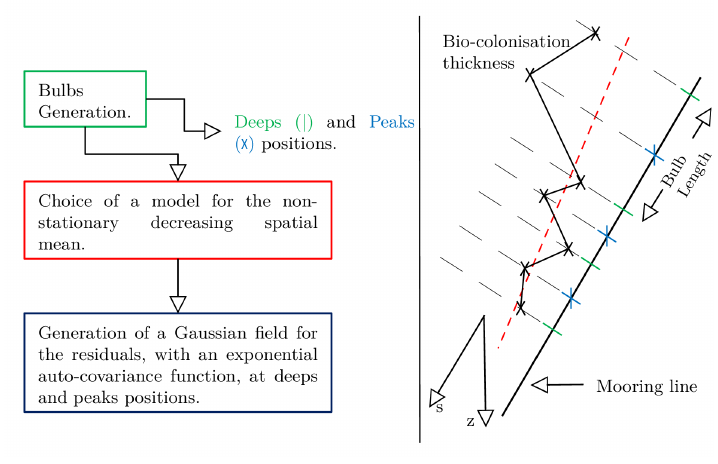
Figure 8. Diagram of the model with a